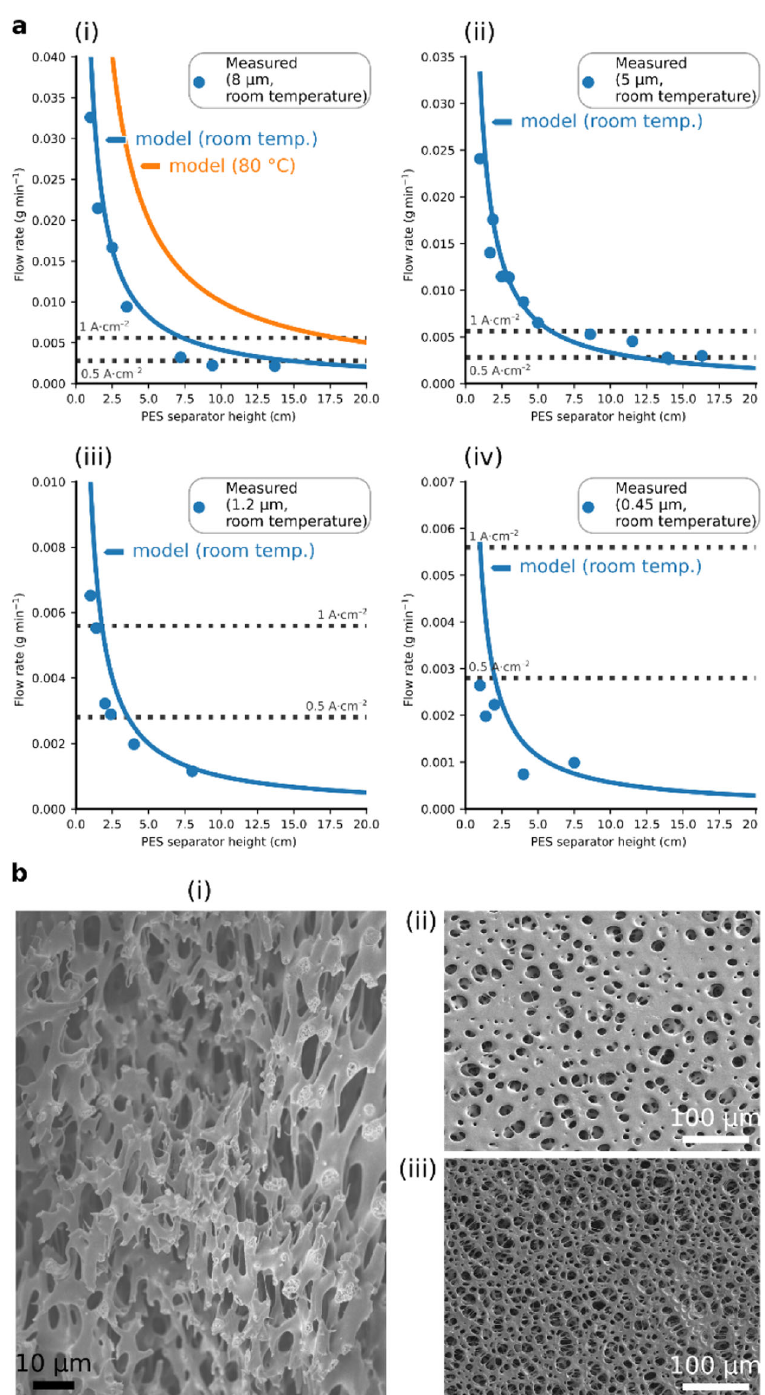
Fig. 2 Capillary-fed inter-electrode separator. a Flow rates at different heights inside a capillary-fed inter-electrode separator. Measured (data points) and modelled (blue line) fl ow rates (Darcy fl ow), at room temperature, of 27 wt% aqueous KOH within polyether sulfone (PES) separators that were speci fi ed as having average pore diameters of: (i) 8 μ m, (ii) 5 μ m, (iii) 1.2 μ m, and (iv) 0.45 μ m. The measured data was obtained as described in the Methods section and Supplementary Fig. 4. The modelled data was obtained as described in the text. The orange line in (i) depicts the modelled fl ow at 80 °C. The dotted lines show the rate of water consumption by a 1 cm 2 water electrolysis cell operating at 0.5 A cm − 2 (lower dotted line) and 1 A cm − 2 (upper dotted line). The capillary-induced fl ow rate within the 8 μ m polyether sulfone separator is suf fi cient to supply water electrolysis at 0.5 A cm − 2 at a height of 15 cm at room temperature, and at 1 A cm − 2 at a height of 18 cm at 80 °C. b Pore structure of the polyether sulfone separator. Scanning electron micrographs of the polyether sulfone fi lter, showing: (i) its structure in cross-section, and (ii) its gloss surface and (iii) its matte